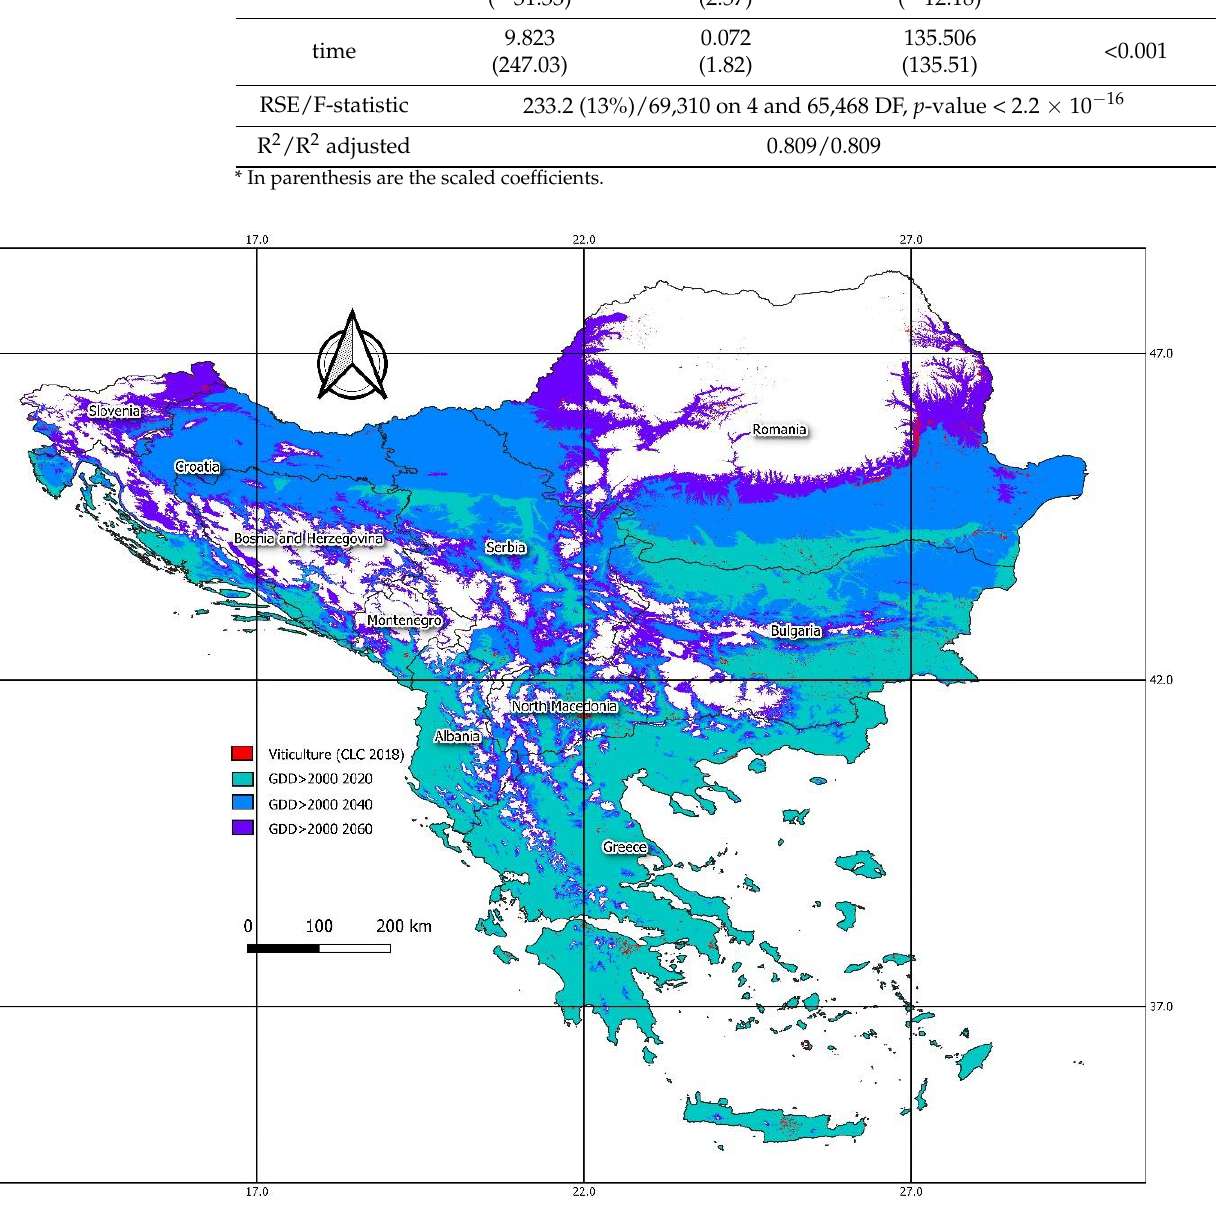
Figure 4. The existing (2018) viticulture areas according to Corine land cover, and the areas which potentially accumulate the threshold of 2000 GDD units during 2020, 2040, and 2060.